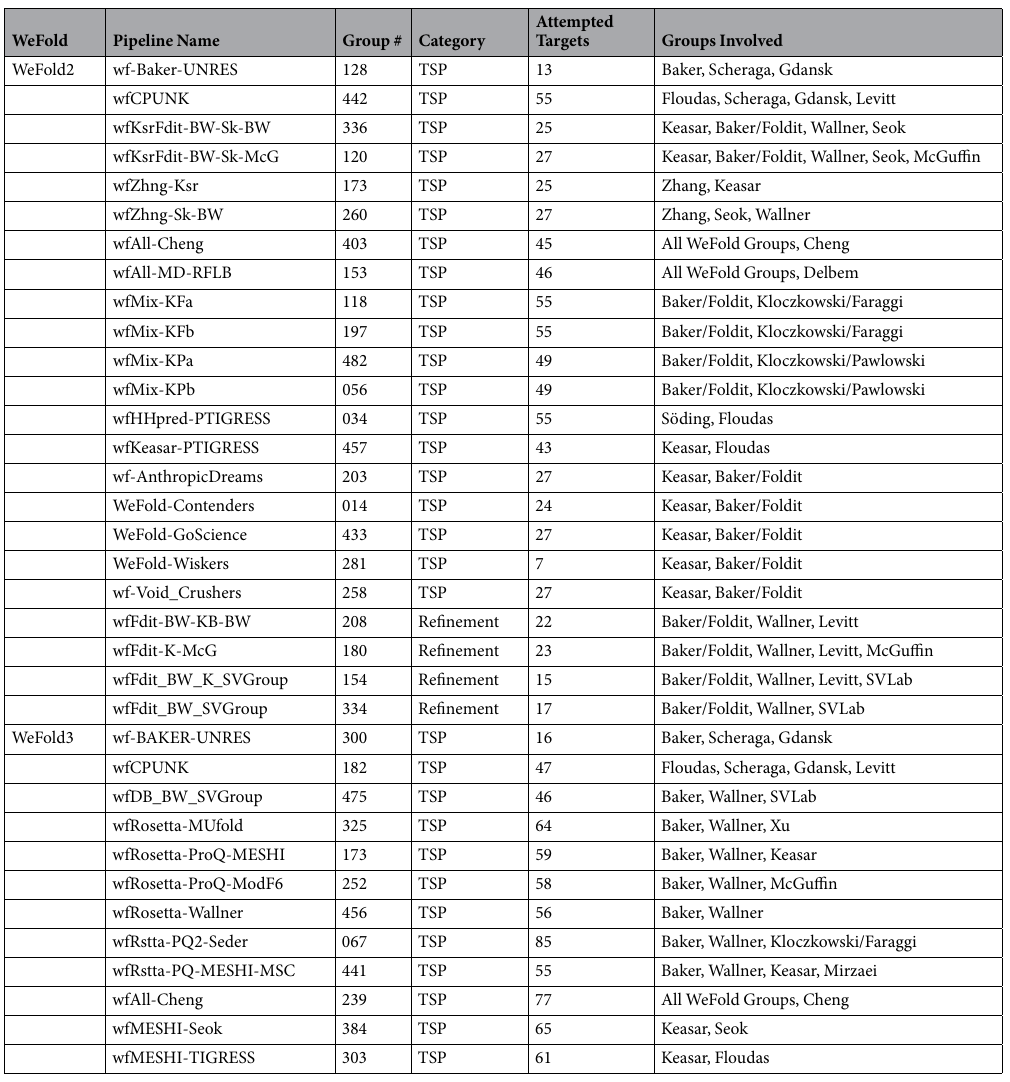
Table 2. Pipelines formed in WeFold2 and WeFold3, with their corresponding group number (assigned by the prediction center upon registration), category (tertiary structure prediction or refinement), number of targets attempted and groups involved. TSP is Tertiary Structure